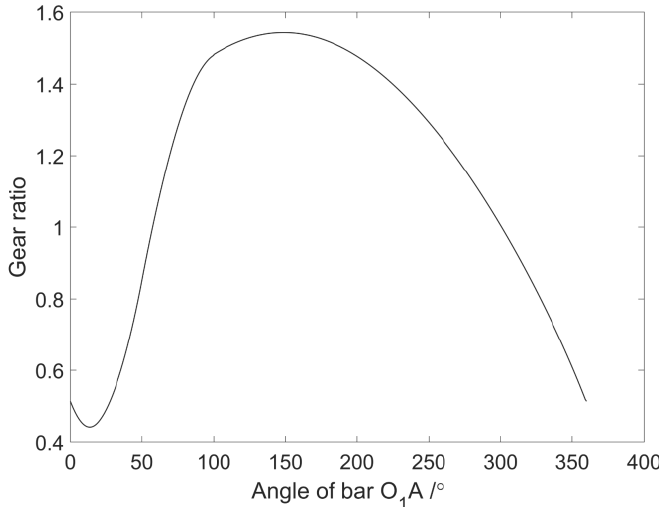
Figure 13. The ratio curve of noncircular gears.